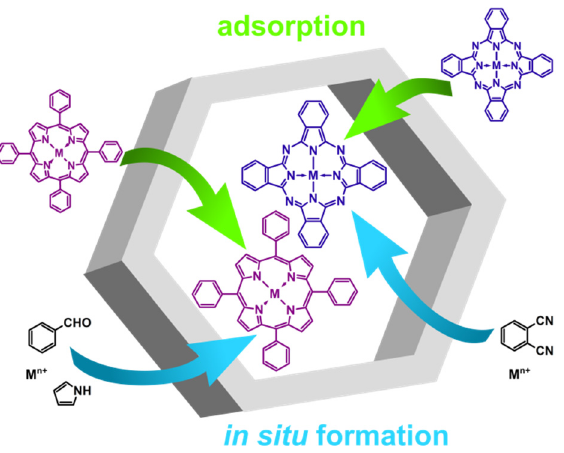
Figure 1. Two methods of immobilization of porphyrins and phthalocyanines into mesoporous materials; adsorption and in situ formation.